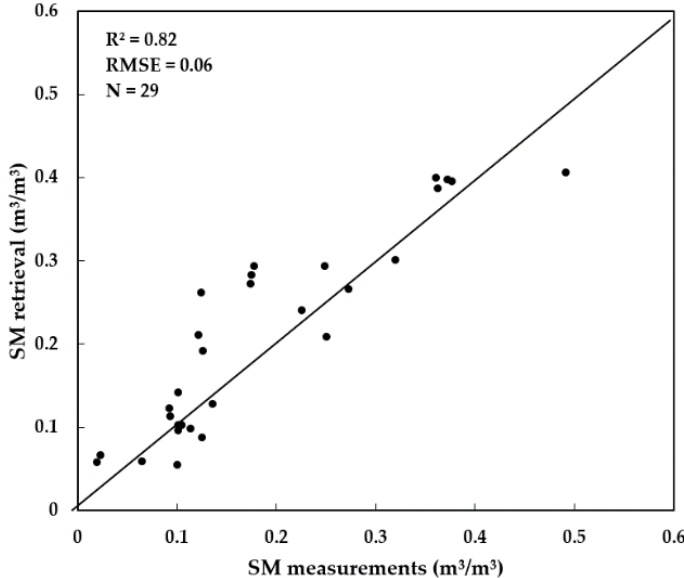
Figure 7. Comparison of SM-retrieved results with measurement data.